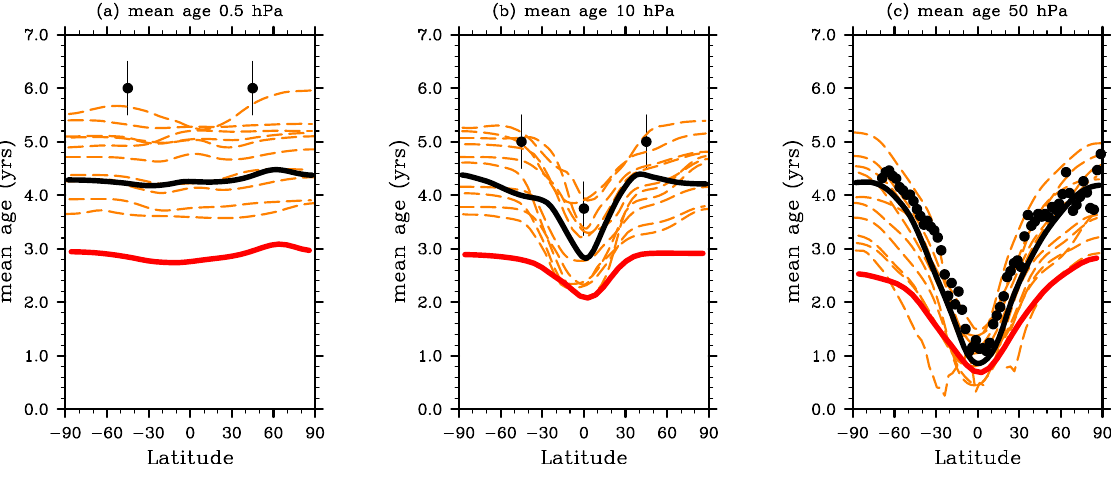
Fig. 4. Mean age of air at (a) 0.5, (b) 10, and (c) 50hPa, observations (black dots ± 1 σ , set text), CNRM-ACM (red line), CNRM-CCM (black line) and CCMVal-2 REF-B1 models (dashed orange lines). Model outputs are from the 1980–2001 period.